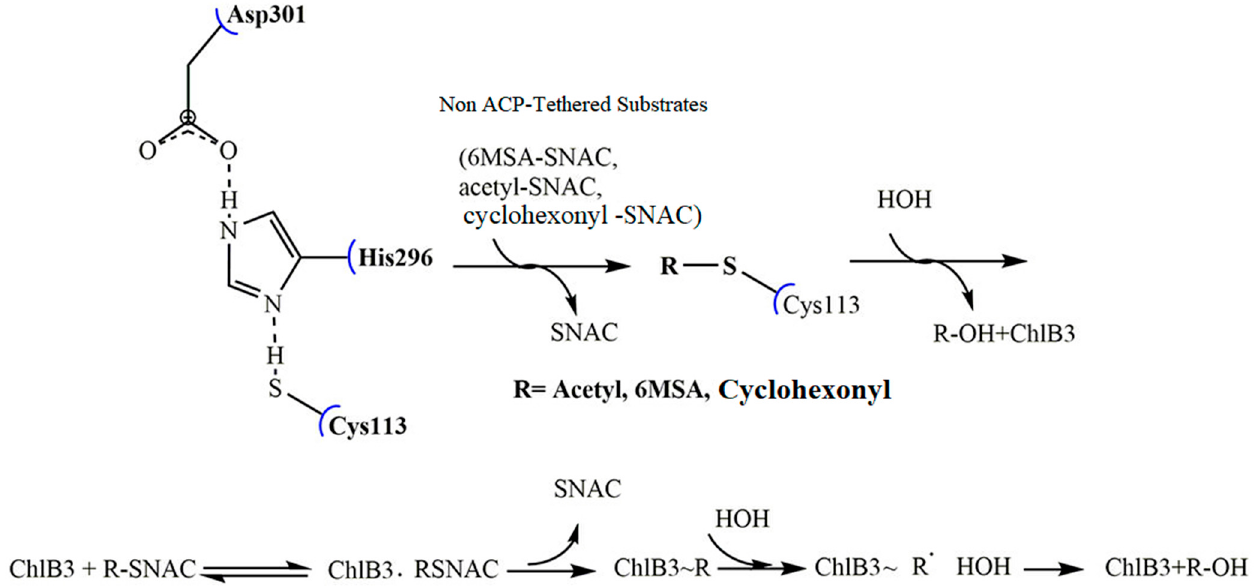
Figure 4. Model of ChlB3 ping-pong bi-bi mechanism. Reaction was initiated by introduction of substrates (6MSA-SNAC, acetyl-SNAC and cyclohexonyl-SNAC) into the active site of protein. Conserved catalytic residues Cys113, His296 and Asp301 hydrolyze the substrate and release the SNAC from R-SNAC.